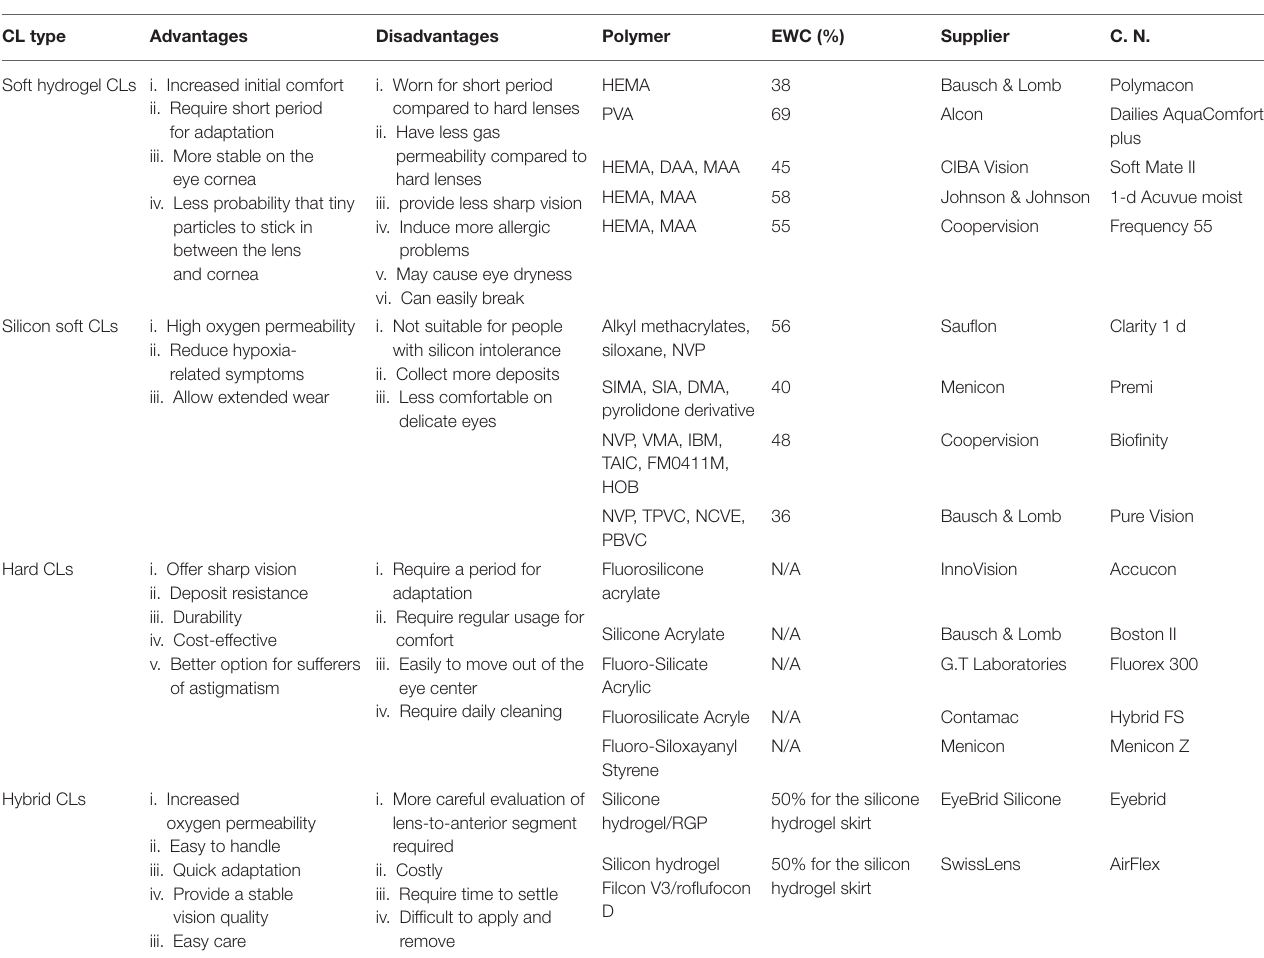
TABLE 1 | Comparison among the different categories of contact lenses and some selected commercial contact lenses (9). CL